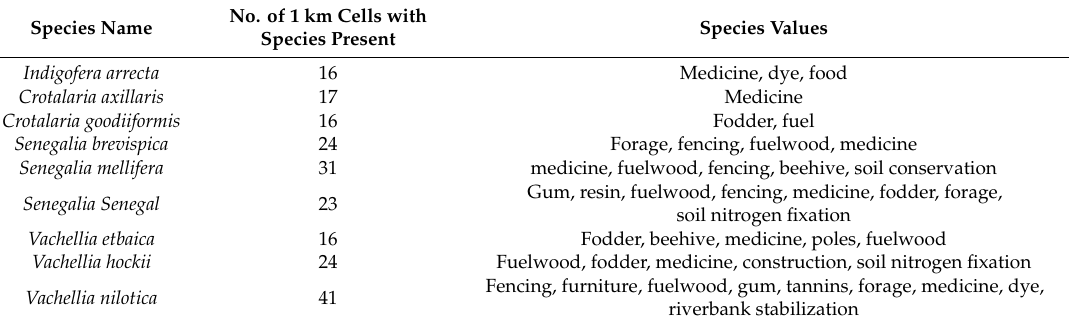
Table 1. Selected Fabaceae species from the Global Biodiversity Information Facility (GBIF) database, number of cells in which they occurred and their values (extracted from